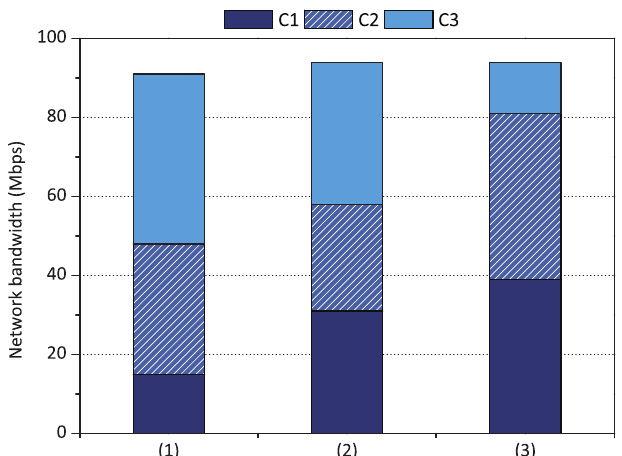
Figure 11. Network performance of the three scheduling policies when (1) proportional share scheduling was applied with weight set 1 to 3 , (2) container C1’s minimum bandwidth reservation was set to 30 Mbps with weight set 1 to 3 , and (3) container C3’s maximum bandwidth limitation was set to 15 Mbps with weight set 1 to 3 and C2’s minimum bandwidth reservation.